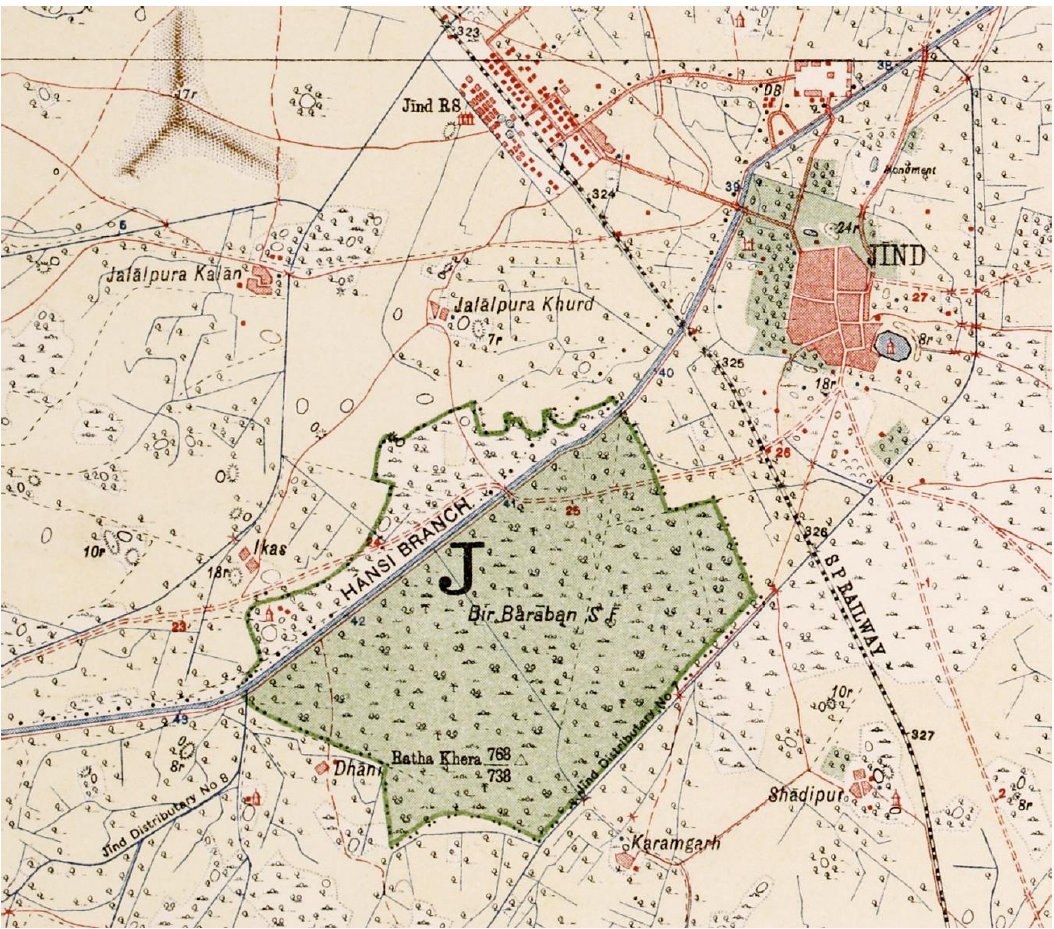
Figure 3. Detail from 1” to 1-mile map sheet 53/C7/1915, showing the types and range of information being documented (e.g., built-up areas, railways, roads, ponds, irrigation canals, cultivated areas, forest, temples) (Image courtesy of Cambridge University Library).